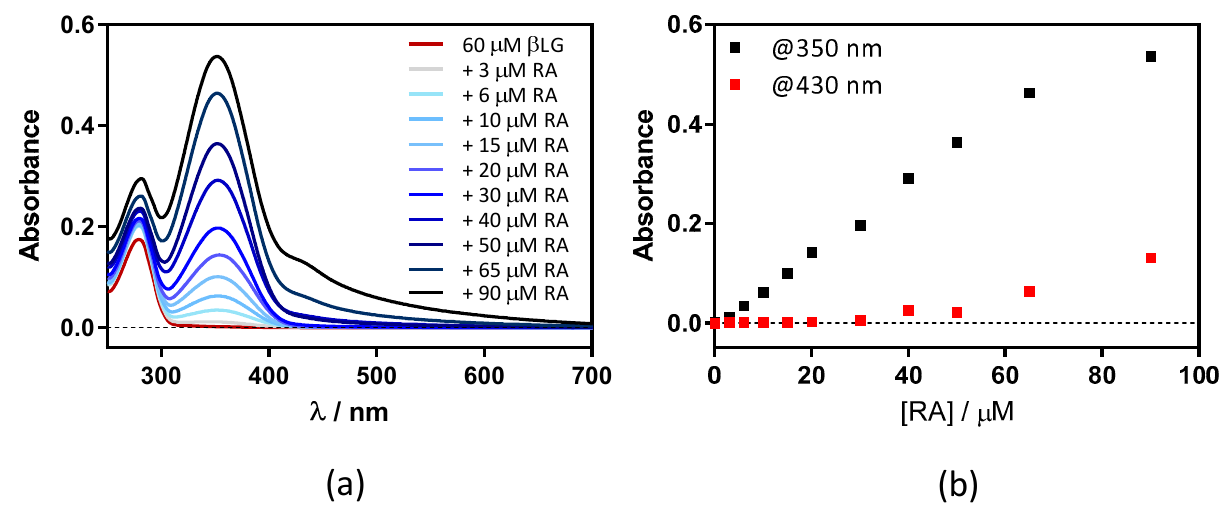
Figure 7. ( a ) Absorption spectra of retinoic acid (RA)– β -lactoglobulin ( β LG) mixtures at increasing RA concentrations (between 0 and 90 μ M). β LG concentration was fixed at 60 μ M. ( b ) The evolution of the absorbance at 350 nm and 430 nm upon titration.